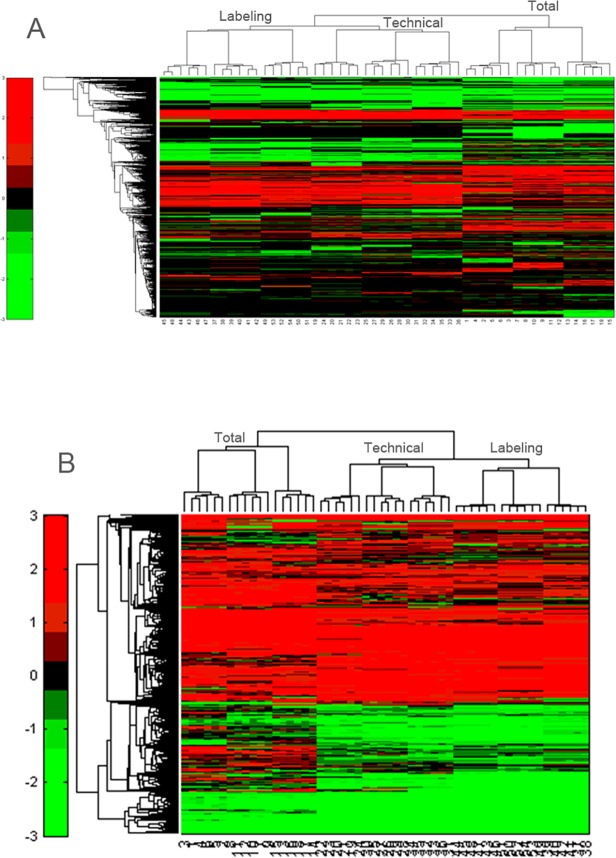
Clustering analysis.Hierarchical clustering on the ‘core’ dataset (A) as well as on the union (B) of all identified and quantified peptides.